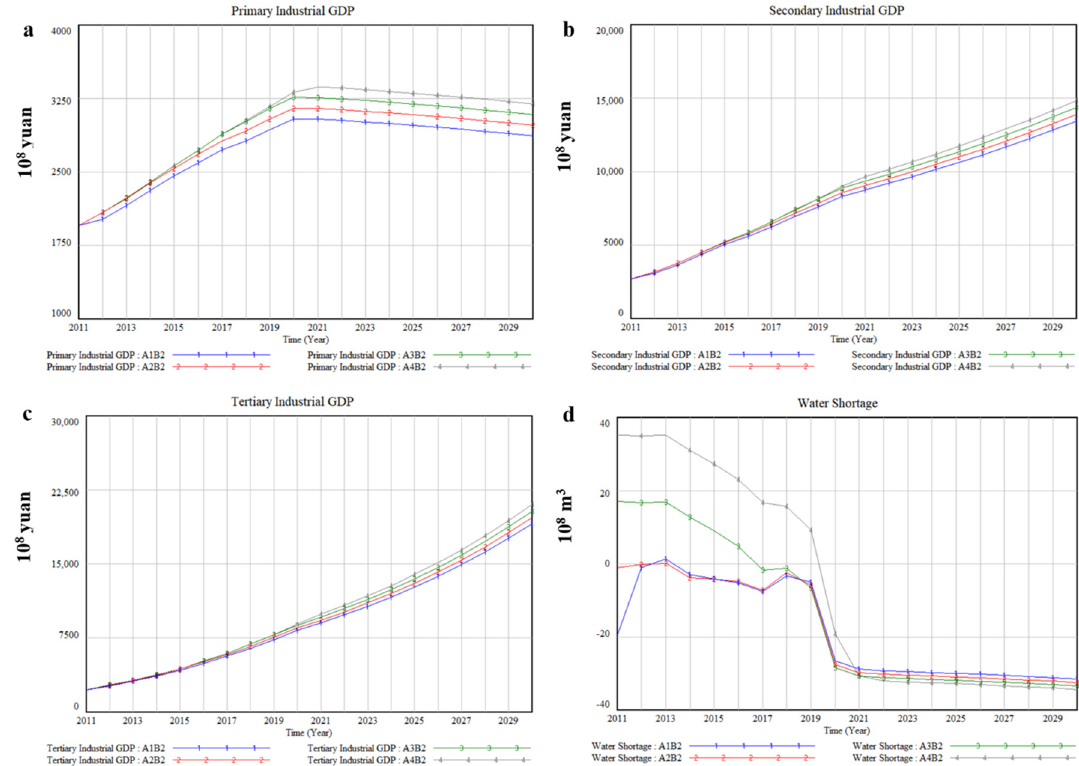
Figure 7. The simulation results of socio-economic and water impacts of 4 water diversion quantity from transboundary river basins under B2, ( a ) Primary Industrial GDP, ( b ) Secondary Industrial GDP, ( c ) Tertiary Industrial GDP, ( d ) Water Shortage.